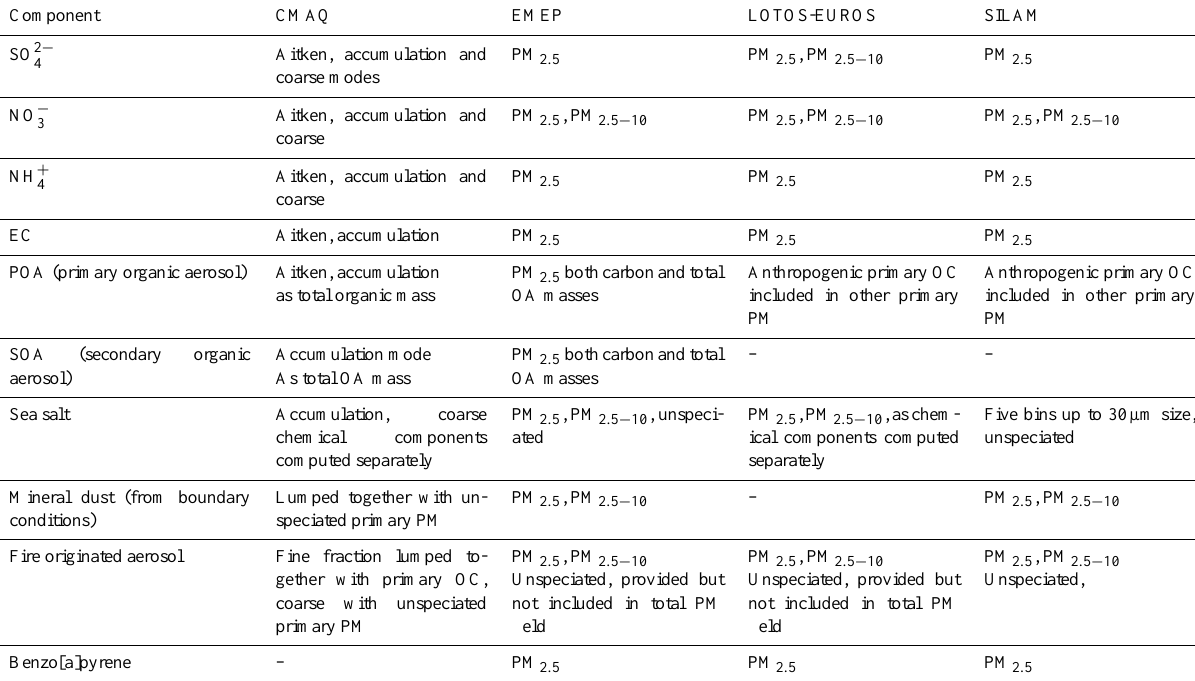
Table 2. The chemical components of PM computed by the different models, particle sizes, speciation and lumping used in the model simulations. The minus signs indicate that the chemical component was excluded from the